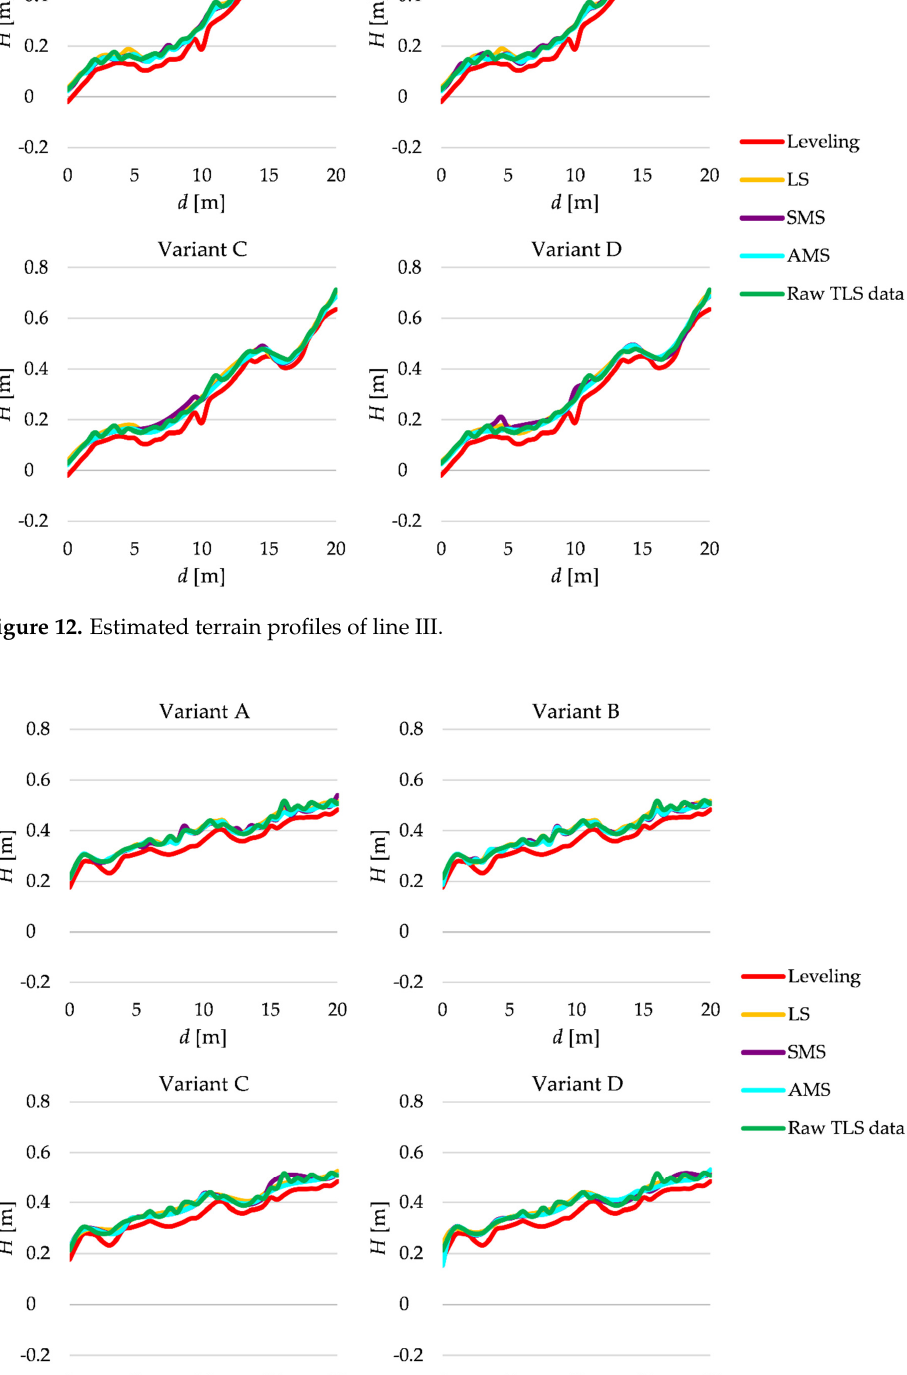
Figure 13. Estimated terrain profiles of line IV.